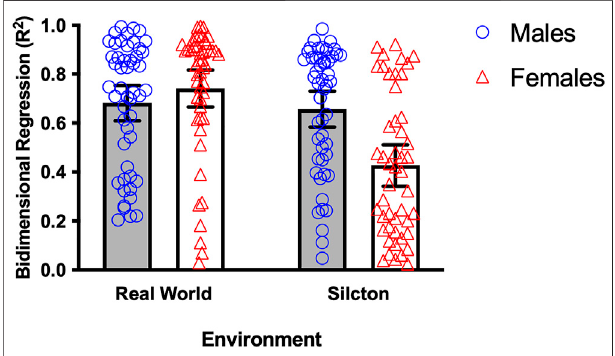
FIGURE 3 | Bidimensional regression means and individual scores for women and men creating maps of Silcton and the real-world locations the participants provided in Experiment 1. Horizontal scatter of the individual scores corresponds to the number of scores at that value (wider = more scores). Error bars show 95% con fi dence